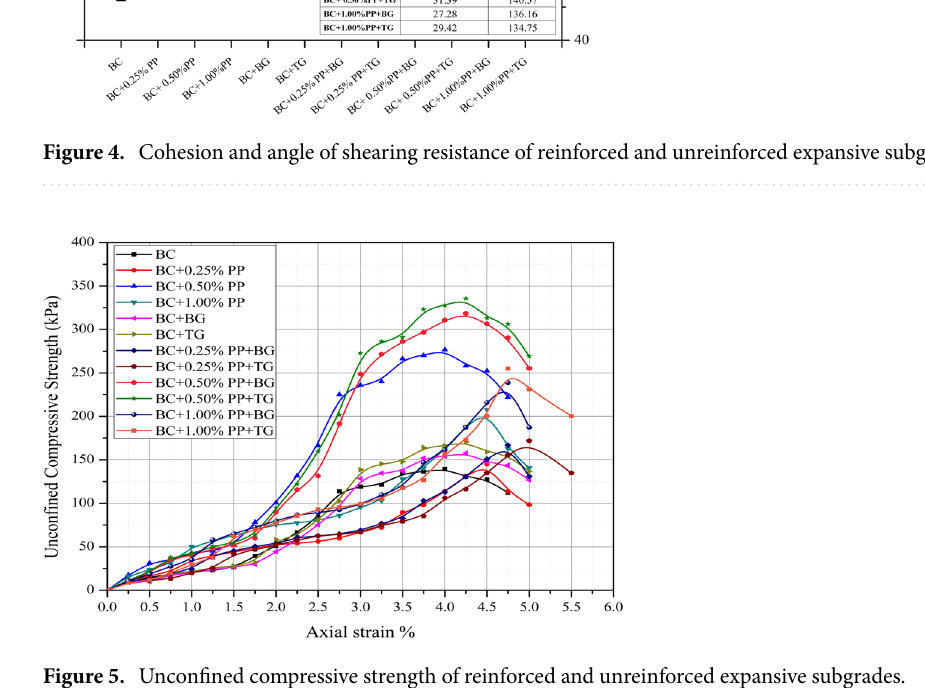
Figure 5. Unconfined compressive strength of reinforced and unreinforced expansive